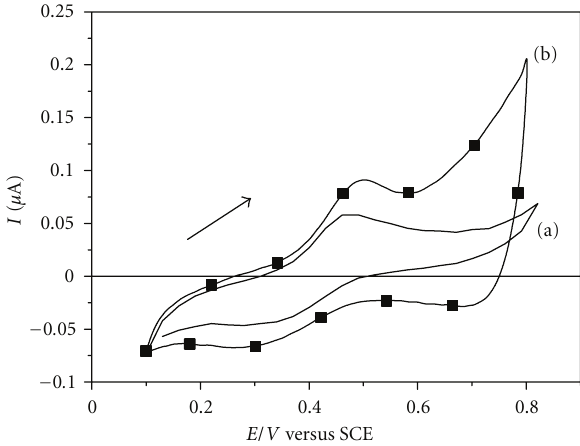
Figure 3: Electrochemical profiles of the films: cyclic voltammo- grams of (a) NiTsPc monolayer onto ITO substrate and (b) ITO/(DS 01/NiTsPc) 3 film. Electrolyte solution H 2 SO 4 0.05 molL − 1 , at 25mVs − 1